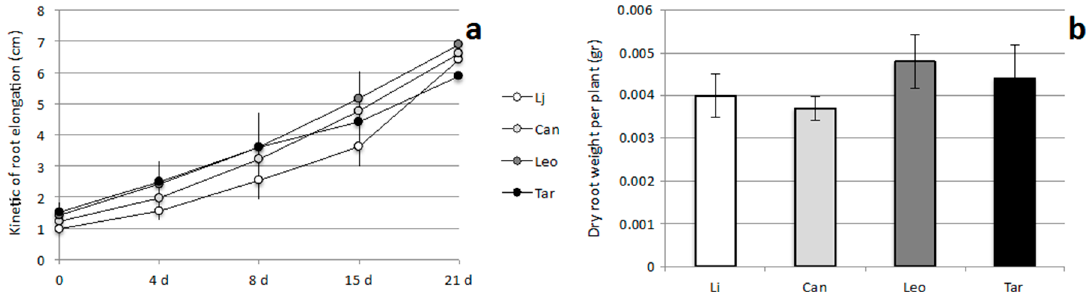
Figure 4. Quantitative analysis of root growth parameters of L. japonicus and L. corniculatus cvs Canetra, Leo and Targovishte 1, grown on complete MS medium. ( a ) Kinetic of root elongation; ( b ) Dry root weight per plant. In panel ( a ) days after transfer on MS medium are indicated on the X axis; at 0 the sizes of roots at the moment of the transfer on MS plates are reported. Data bars represent means and SD of measures from three experiments (10 plants per experiment per condition).